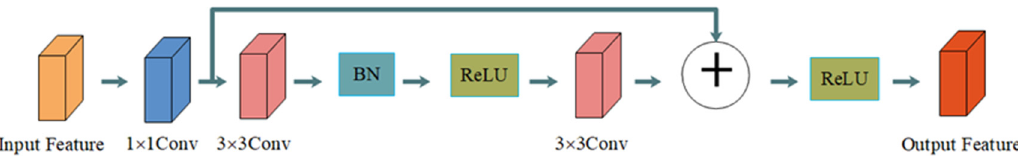
Figure 8. RRB structure. Where: Conv represents convolution layer. ReLU represents the rectified linear units. BN represents the batch normalization.